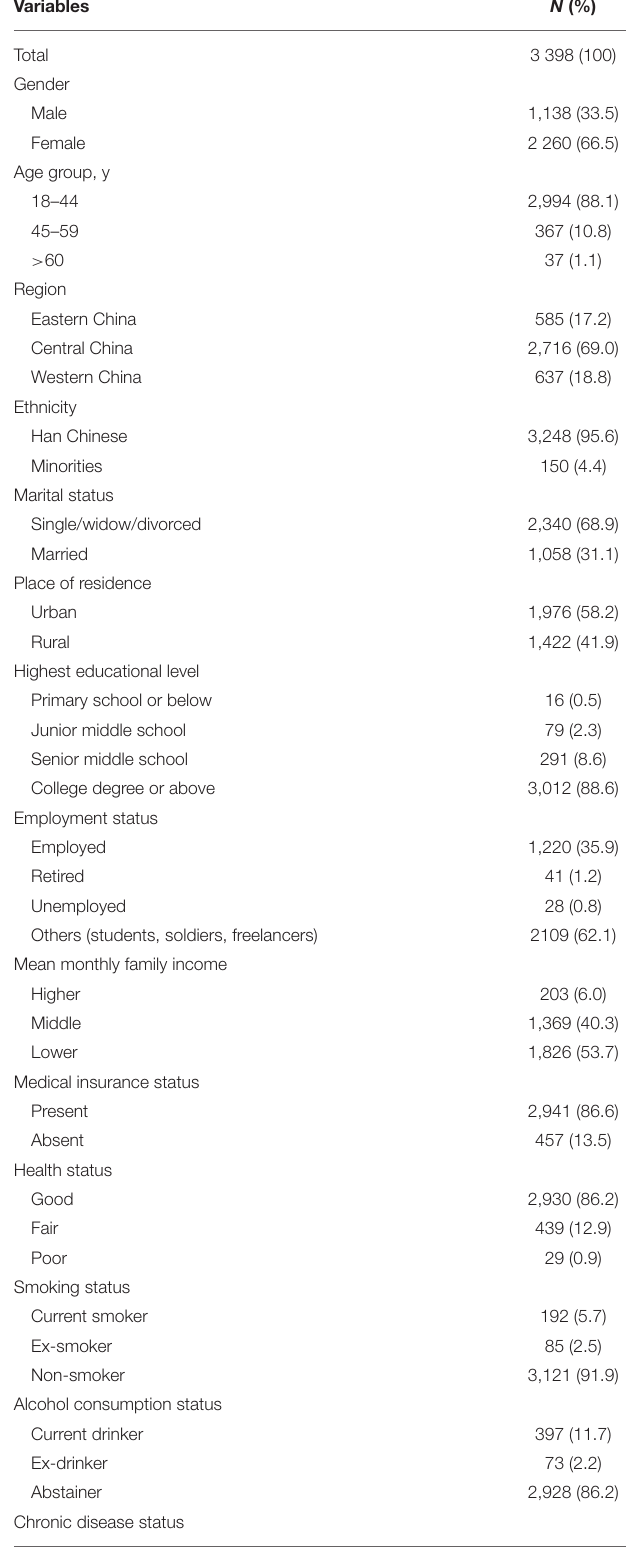
TABLE 2 | Statistical description of study